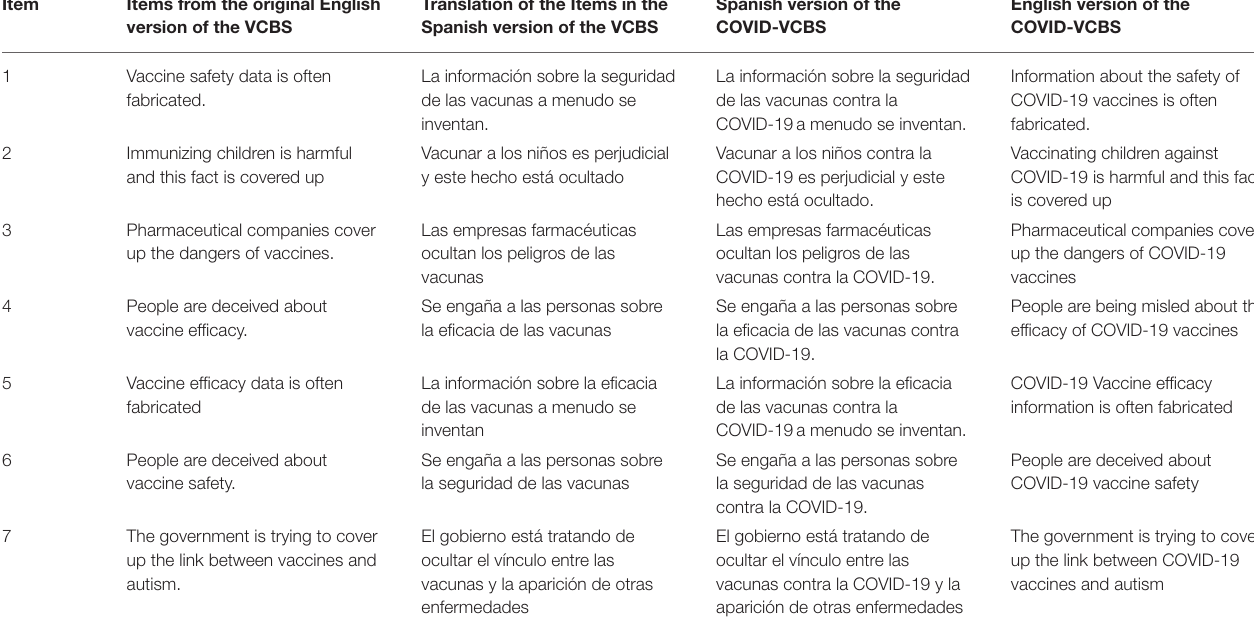
TABLE 2 | Original English version of the VCBS, Spanish version of the VCBS, Spanish version of the COVID-VCBS and English version of the COVID-VCBS.